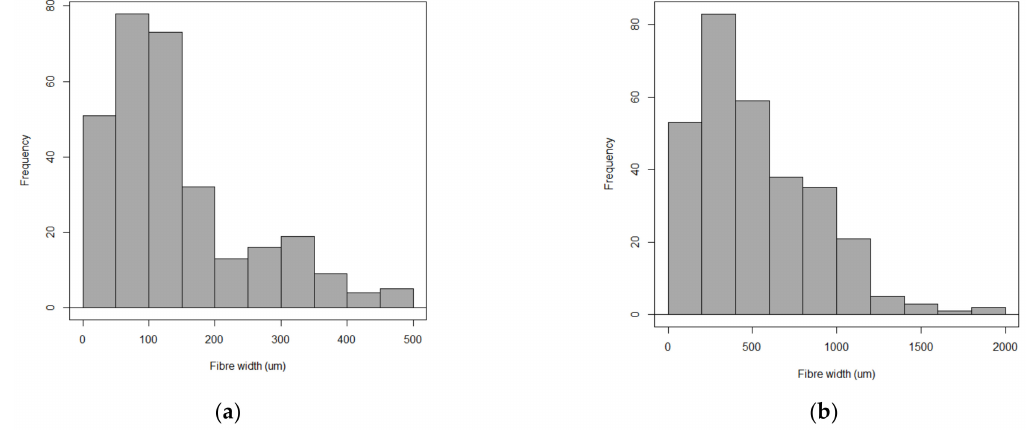
Figure 6. Histogram of fibre bundle width ( µ m) from: ( a ) young OM cladodes (n = 300), ( b ) old OM cladodes (n = 300).